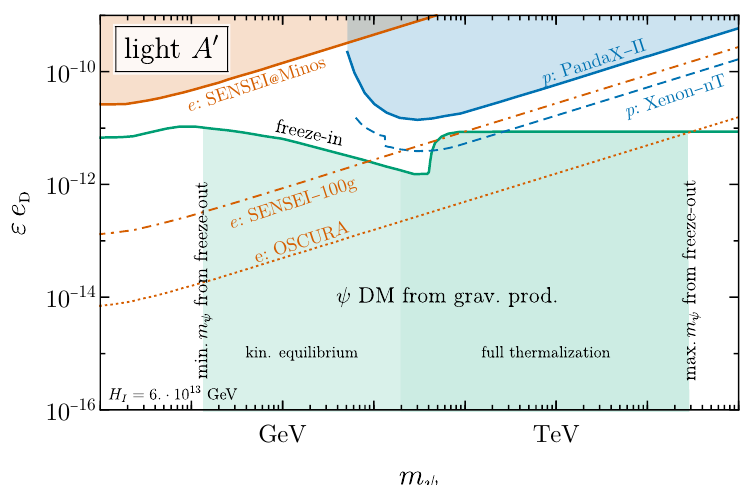
Figure 1. Dark fermion parameter space, for m ψ (cid:29) m A 0 , that can be probed by the mechanism studied in this paper, assuming a kinetic mixing ε between the dark photon and the SM photon (section 5.2). Note that production is independent of this coupling and relies exclusively on the dynamics of the Dark Sector itself (eq. (1.4)). Thus, there is no lower boundary and the green region extends down to arbitrarily small ε . The left and right boundaries are set by the mass range for which the dark fermion can be the dark matter (see figure 6 and surrounding discussions for the difference between “kinetic equilibrium” and “full thermalization”) and the upper boundary corresponds to the standard freeze-in production of dark fermions from the Standard Model via kinetic mixing [18–20]. We also outline current bounds (solid) and near-future projections (dashed, dotted) for direct detection experiments (see section 5.2.3 for